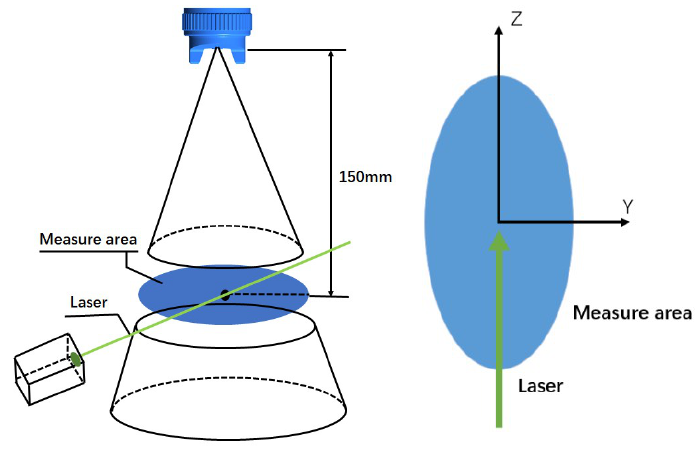
Figure 6. The measurement process of droplet size distribution.